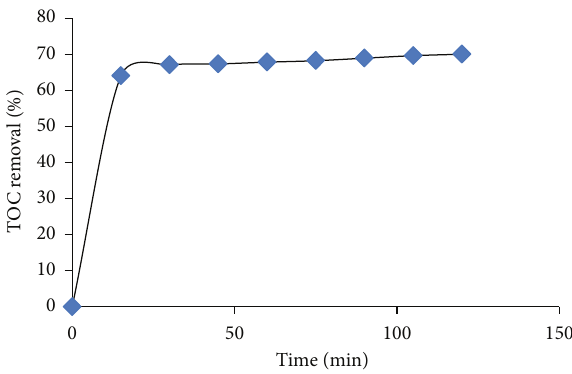
Figure 8: Pseudo-first-order model for Fenton-like oxidation of MAG.